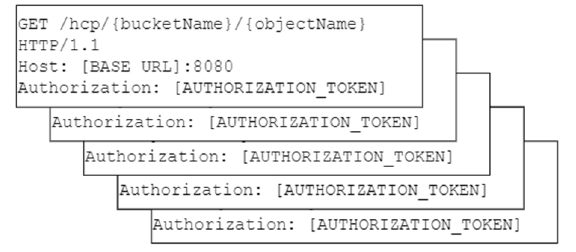
Figure 7. Sample of requests received by the storage cloud.